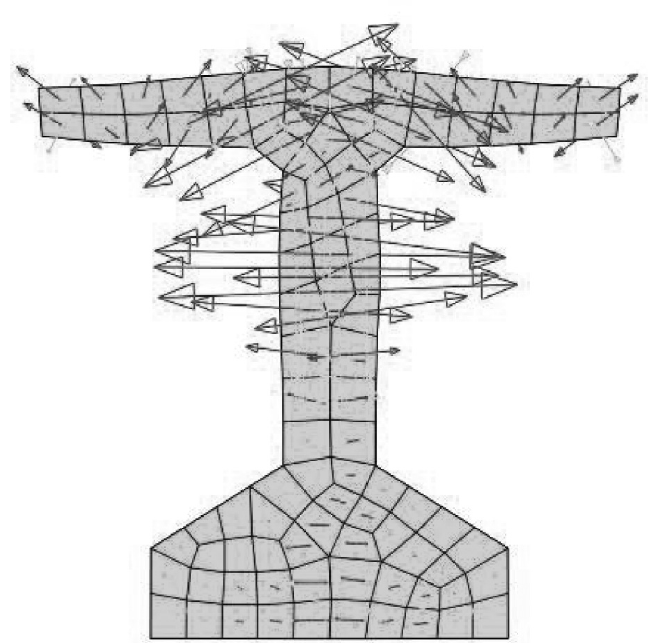
Fig. 10. Web plastic strain from blast above the girder.